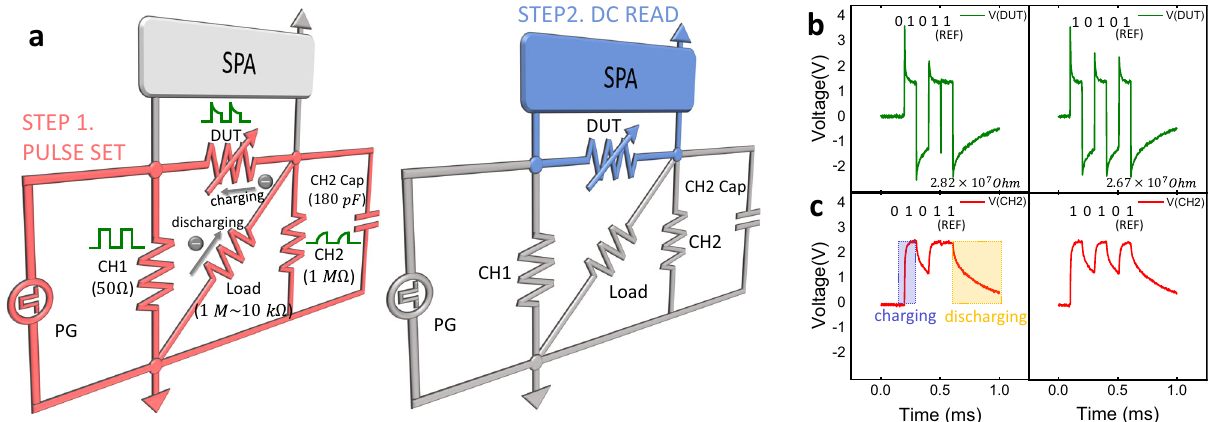
Fig. 2 The circuit used as a temporal kernel in the experiment, and the V-t graphs obtained from the DUT and CH2 of this circuit. a A temporal kernel circuit composed of a memristor, resistors, and a capacitor. CH1 shows the shape of the input pulse stream, and CH2 shows the voltage applied to a 1 M Ω resistor. The voltage across the DUT (green graph) is obtained by subtracting the CH2 voltage from the CH1 voltage. The left panel shows the circuit used in the pulse set (marked by pink) and the right panel shows the circuit used in DC read (marked by blue). b The voltages applied to the memristor with a ‘ 0101 + reference pulse ’ (left) and a ‘ 1010 + reference pulse ’ (right). c The voltages applied to the corresponding CH2, where the 4 V and 0 V voltage amplitudes represent ‘ 1 ’ and ‘ 0, ’ respectively. The voltage across CH2 shows that the charging and discharging rates of the capacitor were asymmetric.